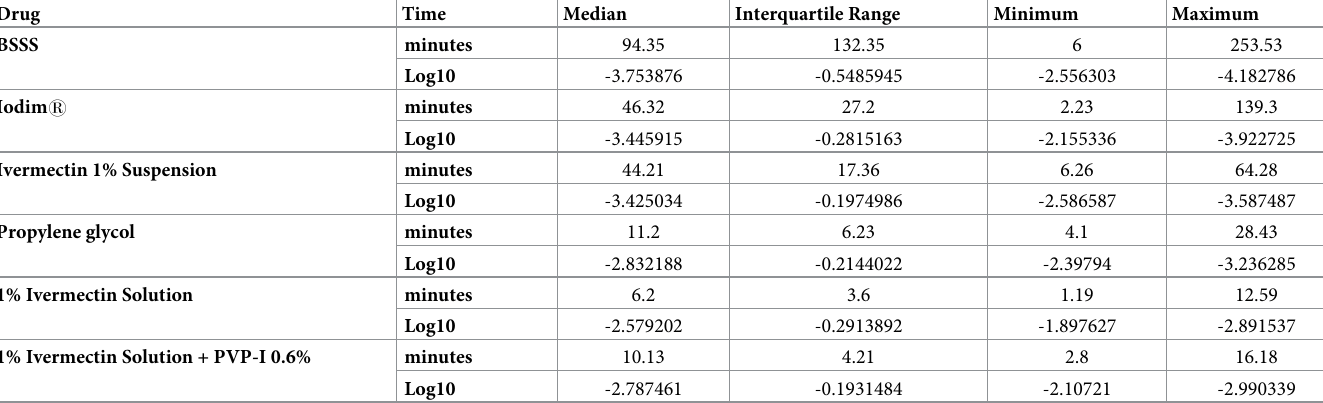
Results of Kaplan-Meyer survival analysis using the log-rank test are reported in Fig 1. The survival curves were significantly lower in the samples treated with ivermectin 1% solu- tion in propylene glycol, ivermectin 1% solution in propylene glycol + 0.6% PVP-I, and pro- pylene glycol than in the samples receiving other treatments or BSSS. Both original data and log10 transformations did not show a normal distribution; however, statistical analysis was performed using the latter. Kruskal-Wallis H test showed a statistically significant difference in time of death between the different drug treatments ( χ 2 [2] = 668.8, with 5 d.f.; p = 0.0001). Dunnet test with Sida´k adjustment for multiple comparisons showed that all drugs tested were significantly more effective than BSSS (p < 0.001). Propylene glycol, the solvent chosen for ivermectin, showed a significantly higher larvicidal activity than Iodim 1 and ivermectin 1% suspension in BSSS (p < 0.001). However, ivermectin